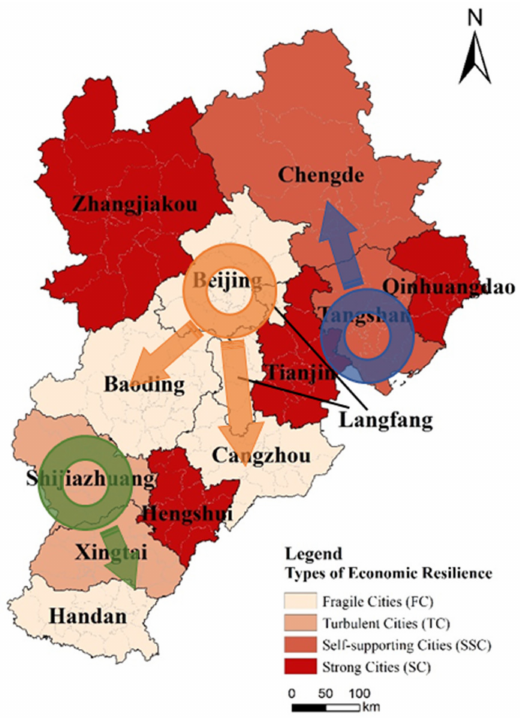
Figure 9. Visualization of economic resilience of Beijing–Tianjin–Hebei urban